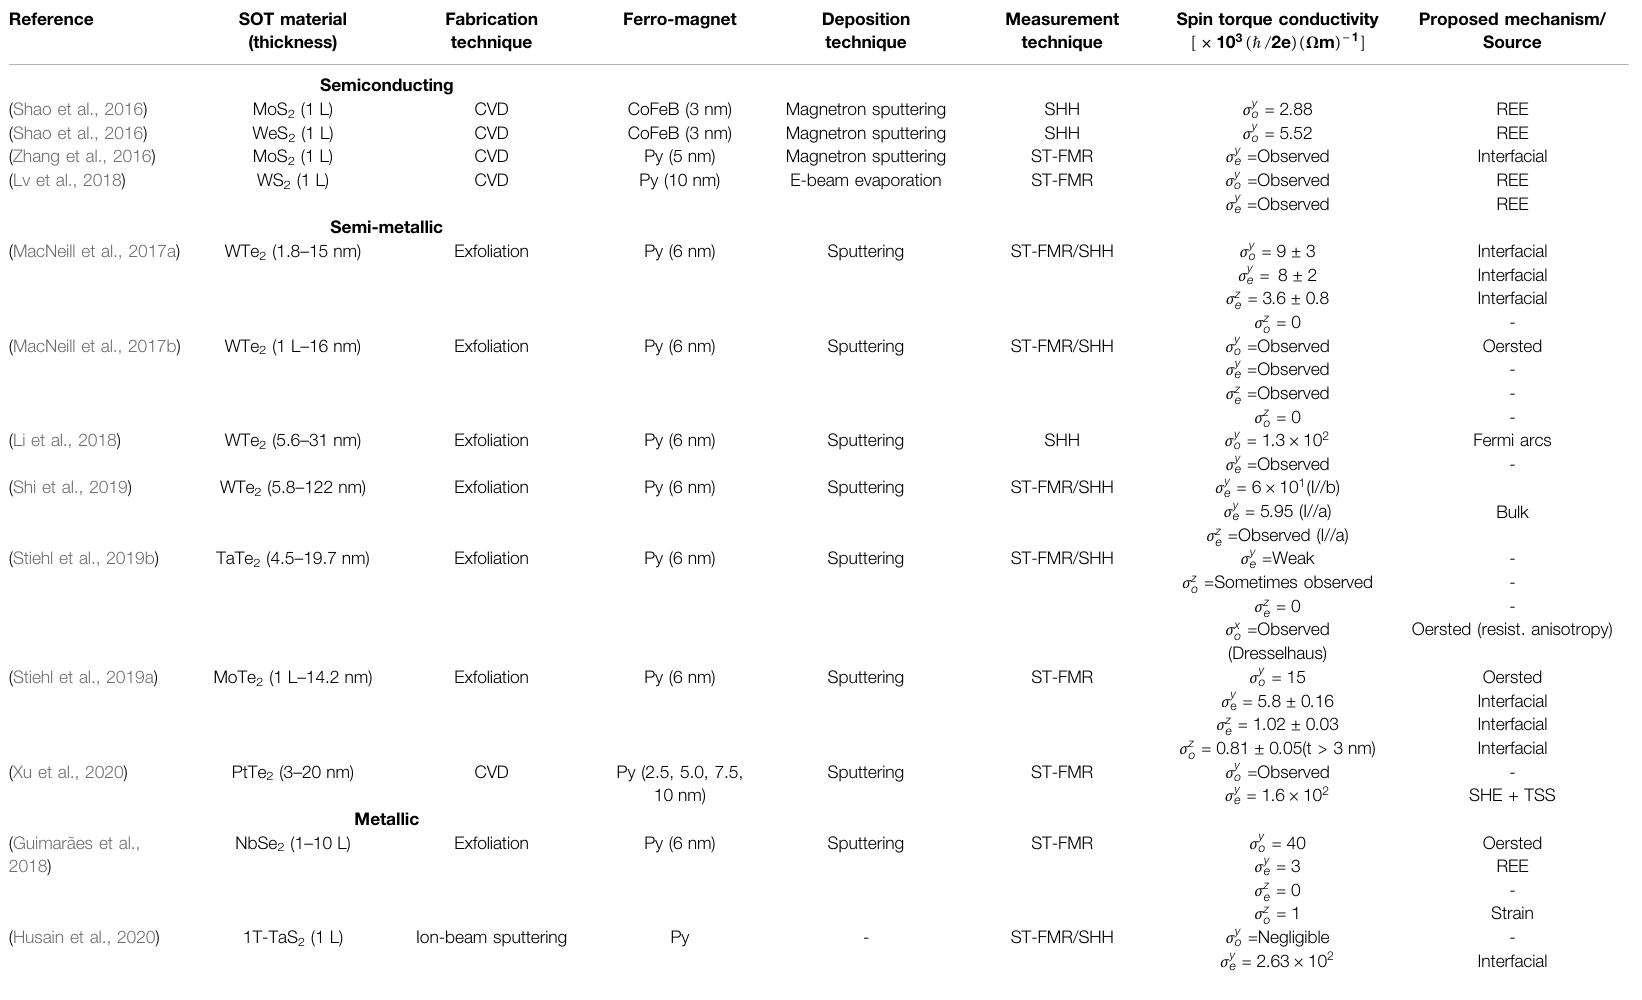
TABLE 1 | Recent studies on TMD/FM heterostructures with their fabrication techniques and spin torque